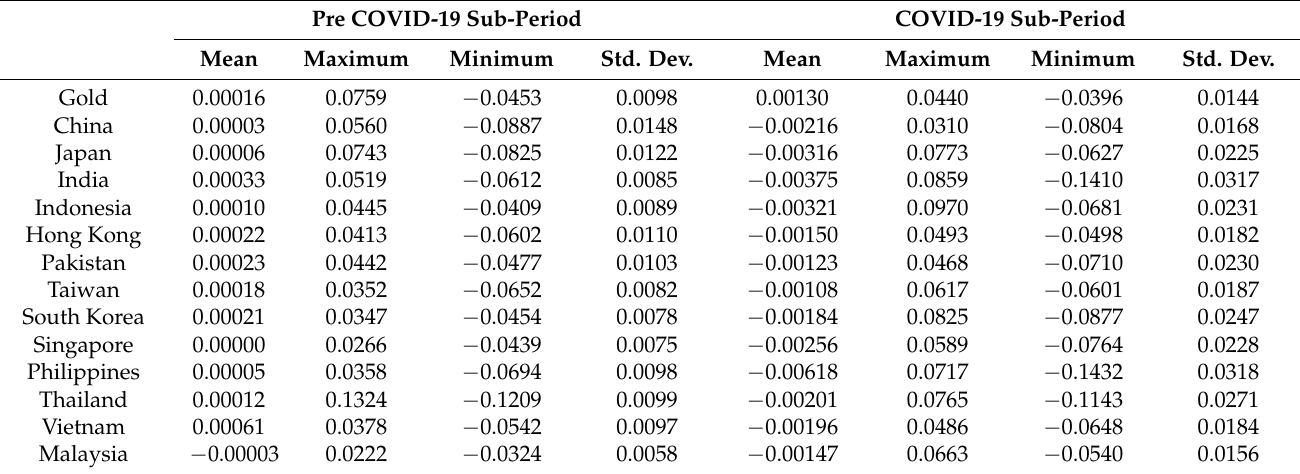
Figure A2. Returns of gold and Asian stock market indices. Table A1. Summary statistics of daily returns.